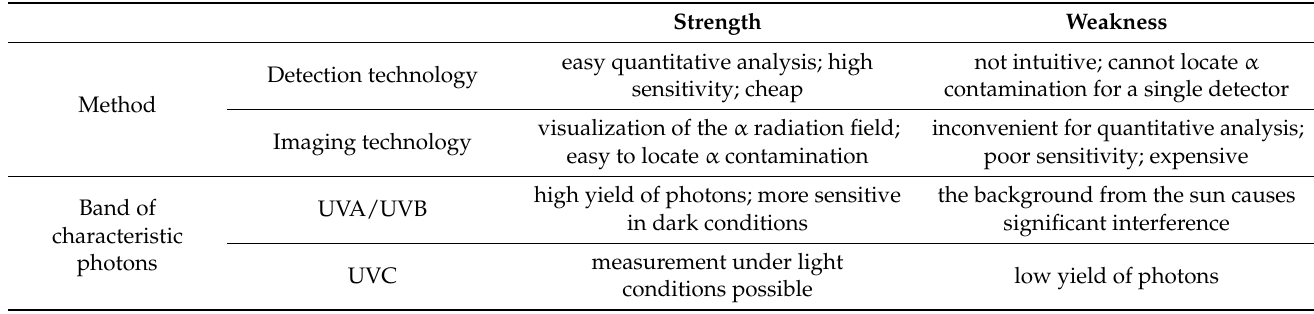
Table 1. Advantages and disadvantages of the main research